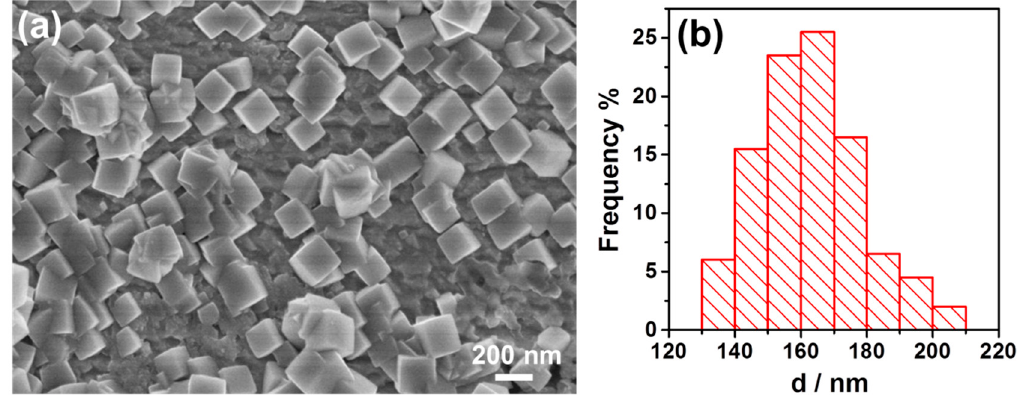
Figure 5. ( a ) SEM of the Rh nanoparticles synthesized for 3min. ( b ) Size distribution of the Rh nanoparticles as synthesized.